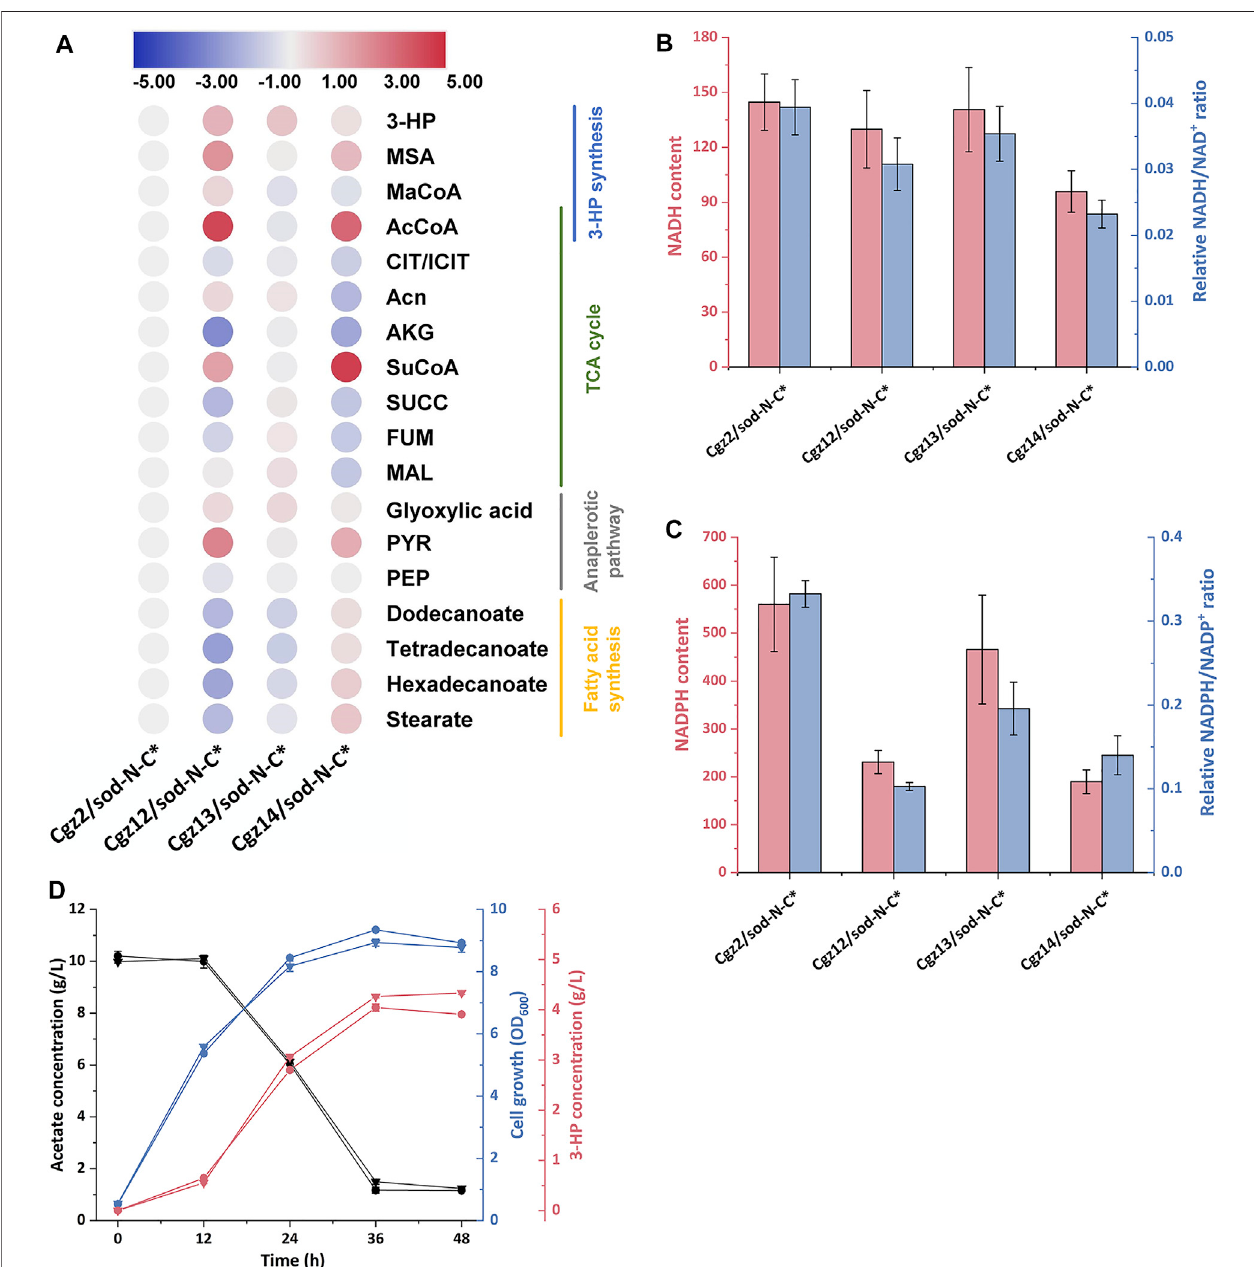
FIGURE5| Changesofintracellularmetabolitesinresponsetodifferentgeneticmanipulations. (A) Heatmap(log 2 foldchange)showingthechangesofintracellular metabolitesinvolvingcentralcarbon metabolism instrainsCgz2/sod-N-C*,Cgz12/sod-N-C*,Cgz13/sod-N-C*,and Cgz14/sod-N-C* at12 h. “ # ” indicatesmetabolites that could not be distinguished in LC-MS. Comparison of intracellular (B) relative NADH content and NADH/NAD + ratio, and (C) relative NADPH content and NADPH/ NADP + ratio in strains Cgz2/sod-N-C*, Cgz12/sod-N-C*, Cgz13/sod-N-C*, and Cgz14/sod-N-C* at 12 h. (D) Time pro fi le of cell growth (OD 600 ), acetate, and 3- HP concentrations of Cgz12/sod-N-C* and Cgz14/sod-N-C* with addition of 15 μ M cerulenin at 12